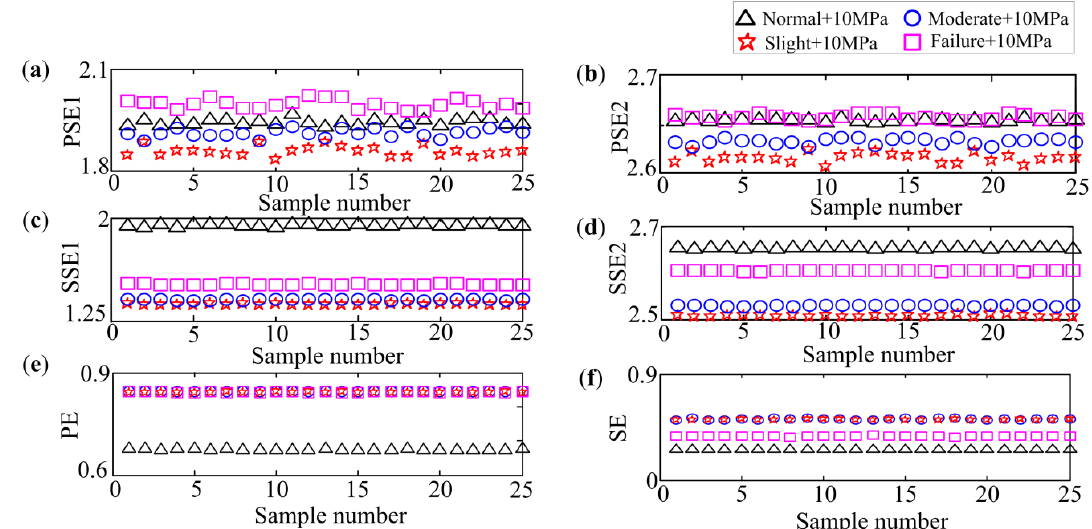
Figure 13. Six kinds of information entropies. ( a ) Power spectrum Shannon entropy (PSE1); ( b ) power spectrum exponential entropy (PSE2); ( c ) singular spectrum Shannon entropy (SSE1); ( d ) singular spectrum exponential entropy (SSE2); ( e ) permutation entropy (PE); ( f ) sample entropy (SE).